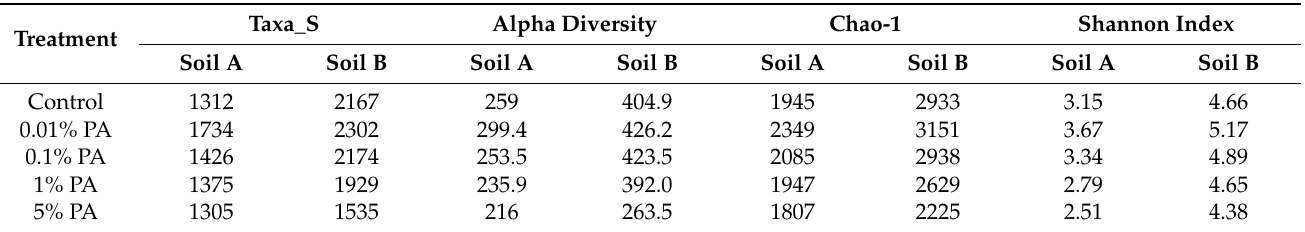
Table 2. Estimated richness and diversity indices of Soil A and Soil B spiked with different concentra- tions of PA.